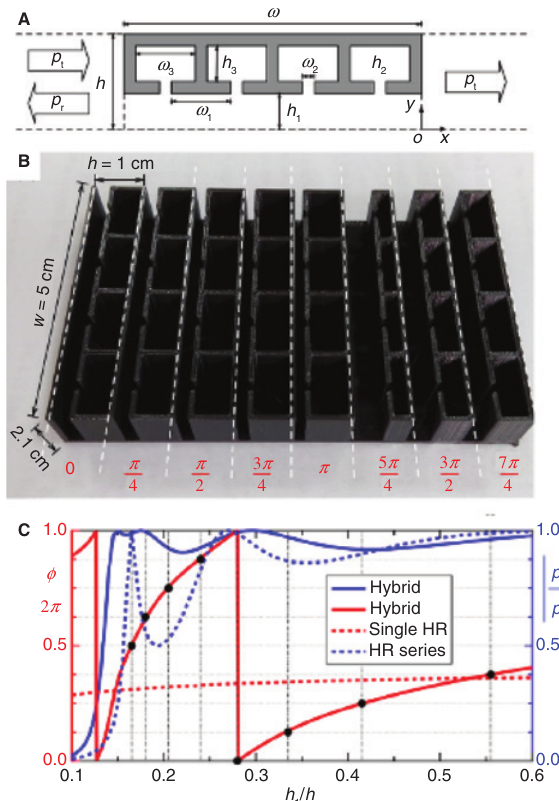
Figure 5: Design and implementation of transmission-type acoustic